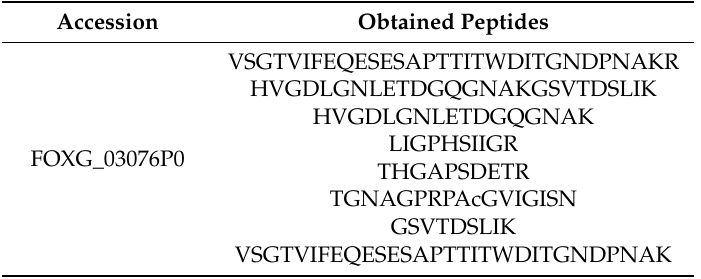
Figure 9. The amino acid sequence of SOD identified from F. oxysporum (FoSOD). Black rectangles showed the Cu-binding residues. Black circles showed the Zn-binding residues. Table 1. Result of liquid chromatography/mass/mass (LC/MS/MS) analysis of superoxide dismutase. Accession